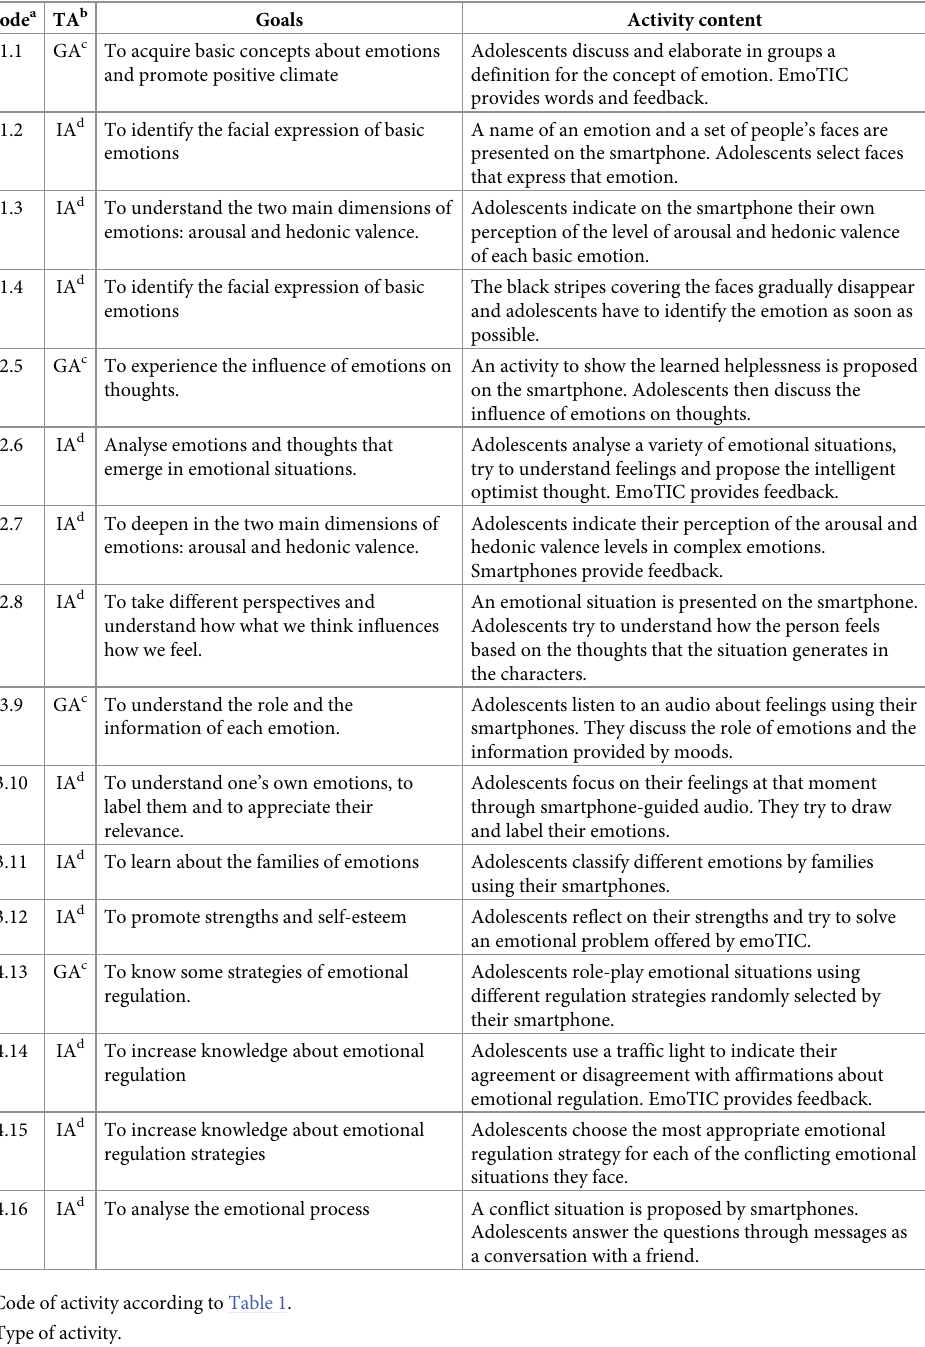
Table 2. Sessions, type of activity, goals, and activity content of the programme. Code a TA